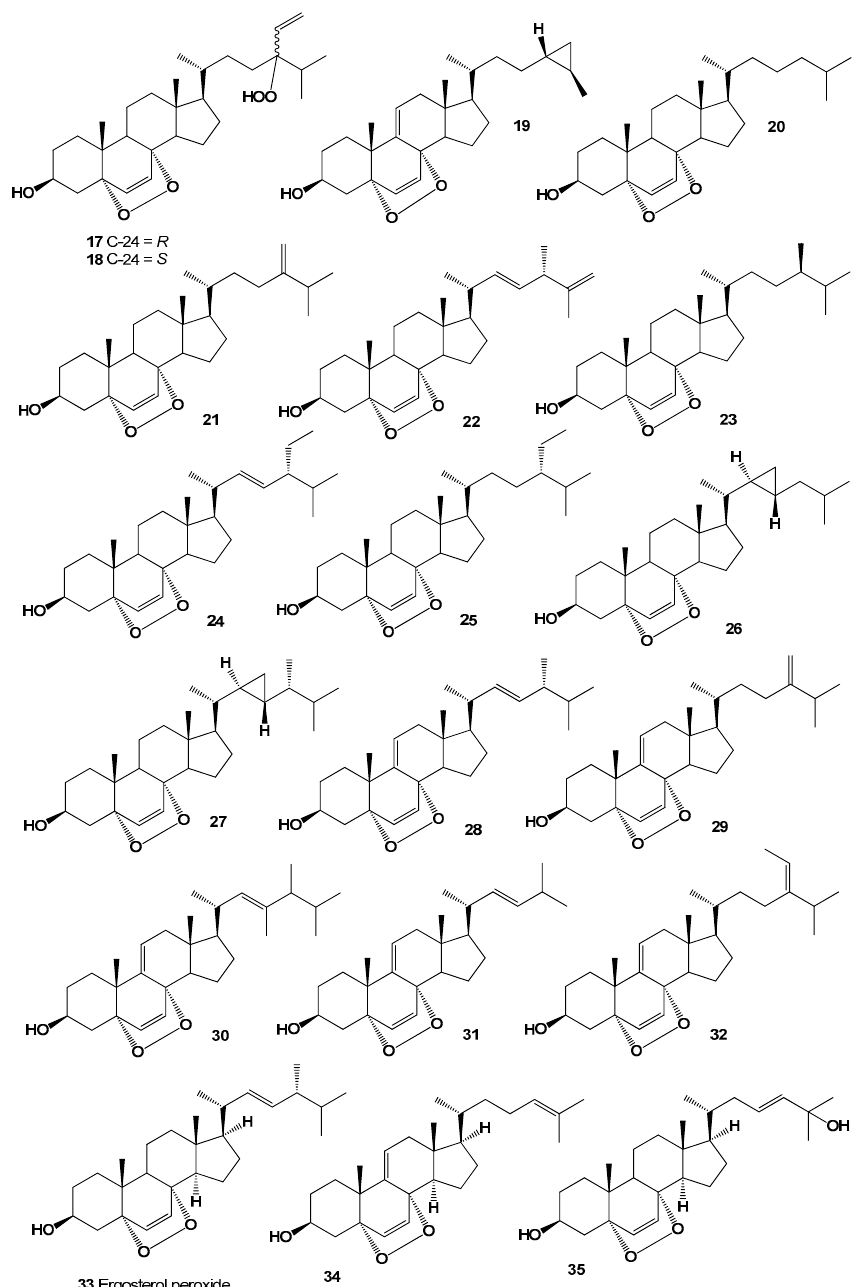
Figure 2. Bioactive polycyclic endoperoxides derived from marine sources.